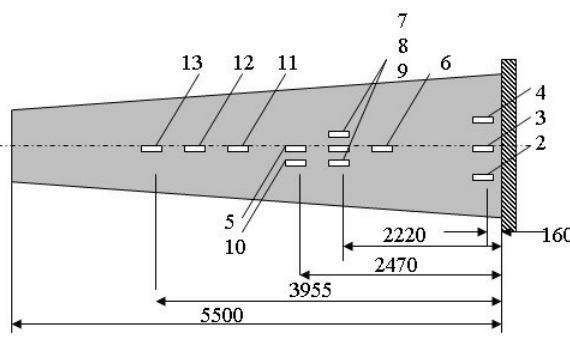
Fig 3. Scheme of location of strain gauges on outer surface of tail